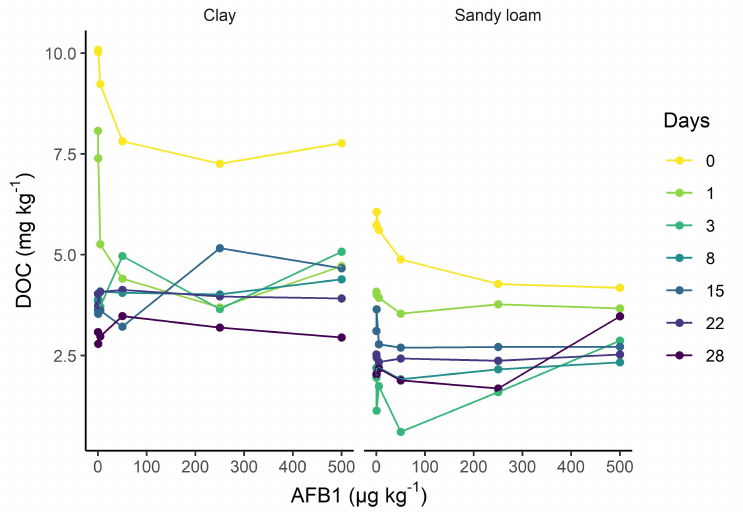
Figure A7. Dissolved organic carbon in the nonfumigated sandy loam and clay soils as a function of AFB1